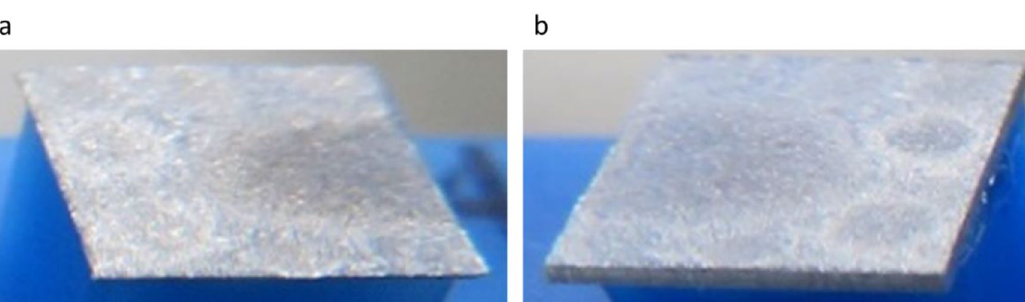
Figure 2. Photographs of laser-sliced 5 × 5 mm square GaN substrates. ( a ) Separated part of GaN substrate with thickness of 60 µm. ( b ) Separated part of GaN substrate with thickness of 340